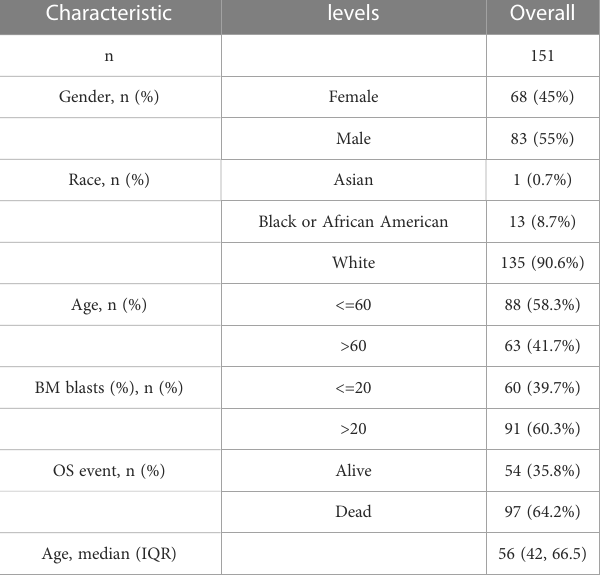
TABLE 1 Patient Characteristics of LAML patients in the TCGA datasets. Characteristic